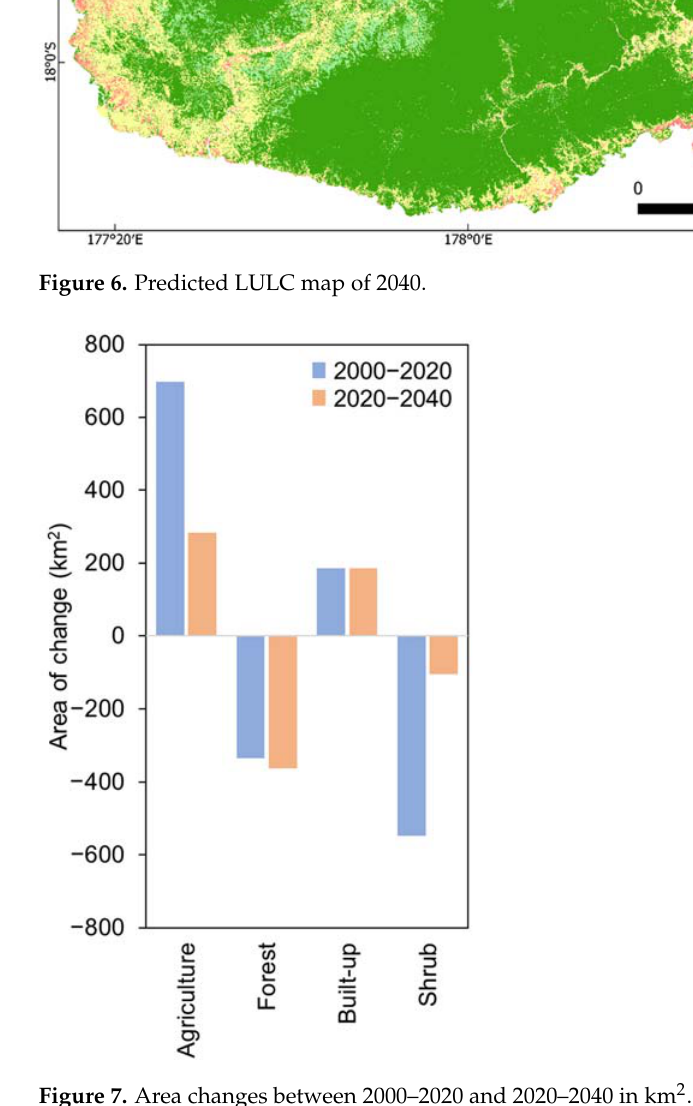
Figure 7. Area changes between 2000–2020 and 2020–2040 in km 2 .